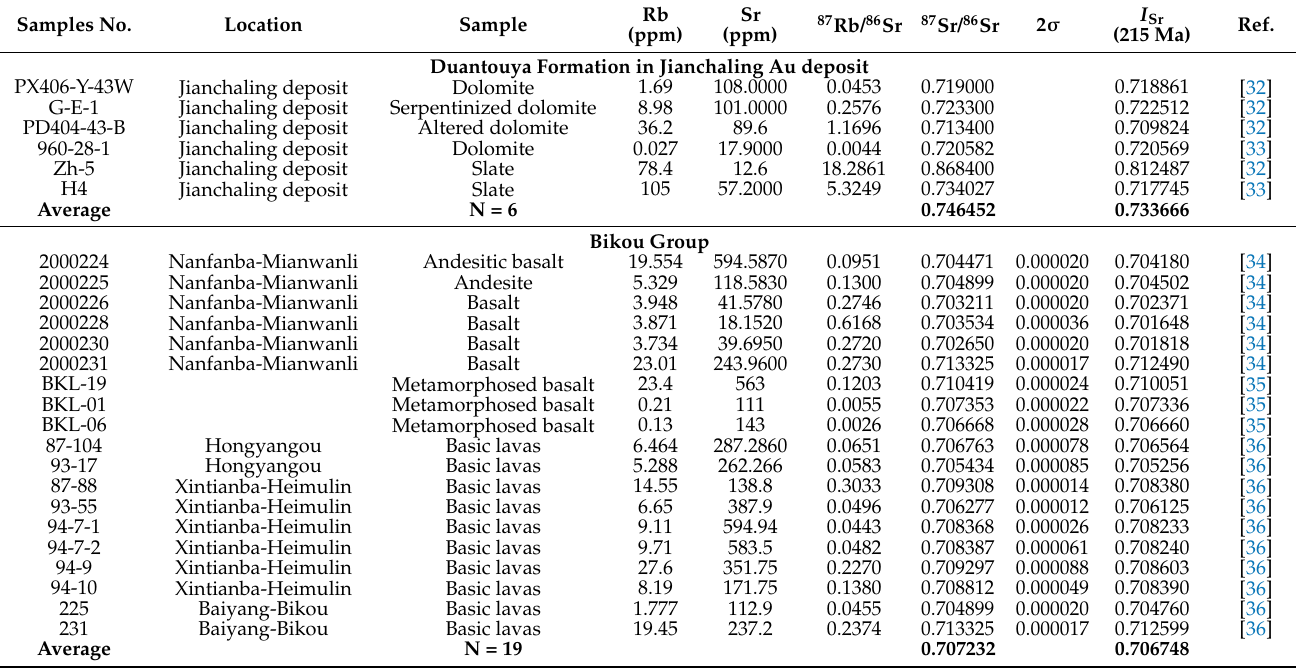
Table 2. The Sr isotope ratios of sphalerite from the Liushuping Au–Zn deposit and wallrocks from the Bikou